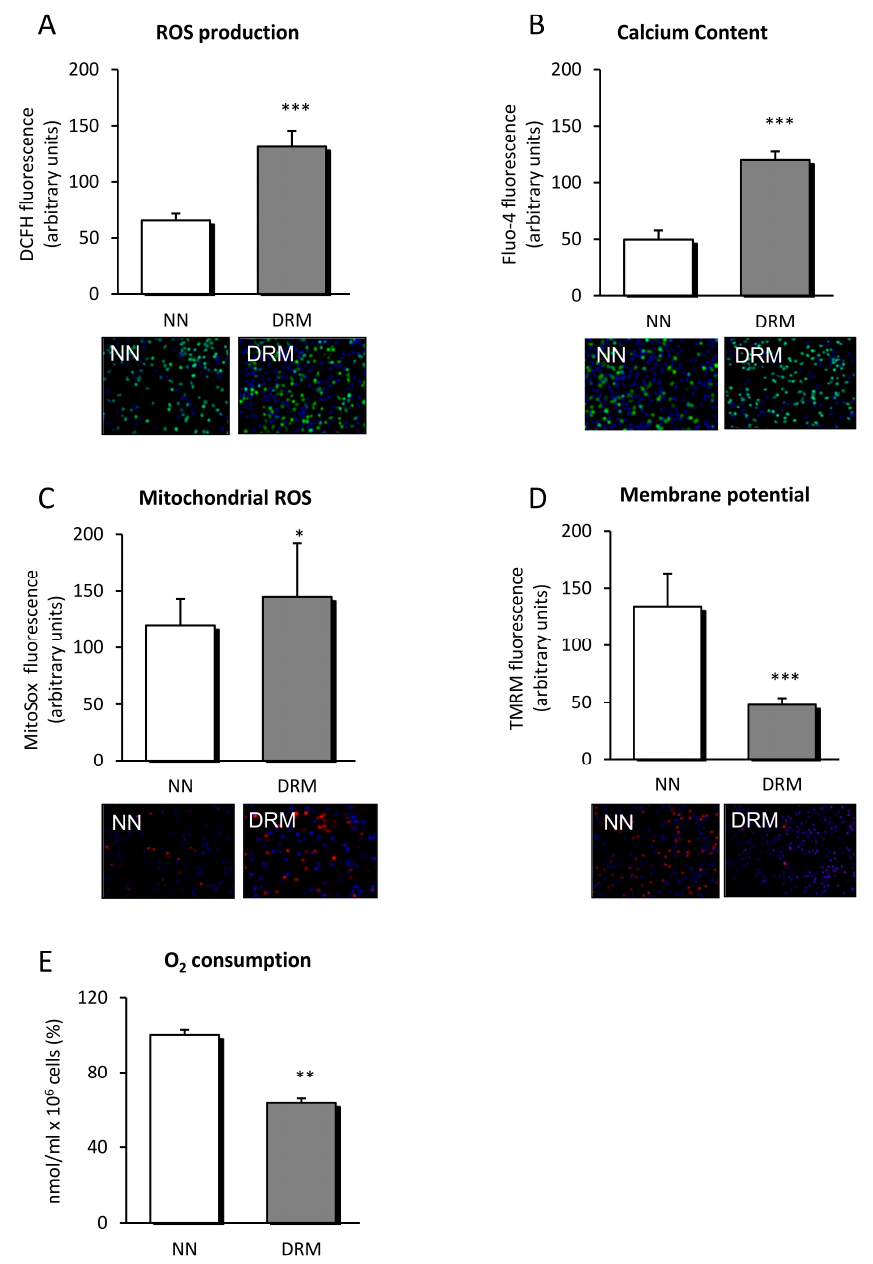
Figure 2. ROS production, calcium content and parameters of mitochondrial function measured in leukocytes from NN and DRM patients. ( A ) ROS production of leukocytes from NN and DRM subjects determined by measuring DCFH fluorescence in arbitrary units. Representative fluorescence images of both groups are displayed below the graph. ( B ) Calcium content of leukocytes from NN and DRM subjects determined by measuring Fluo-4 fluorescence in arbitrary units. Representative fluorescence images of both groups are displayed below the graph. ( C ) Mitochondrial ROS content of leukocytes from NN and DRM subjects, measured by TMRM fluorescence, in arbitrary units. Representative fluorescence images of both groups are displayed below the graph. ( D ) Mitochondrial membrane potential of leukocytes of NN and DRM subjects measured by TMRM fluorescence in arbitrary units. Representative fluorescence images of both groups are displayed below the graph. ( E ) Oxygen consumption of leukocytes from NN and DRM subjects with an oximeter. * p < 0.05, ** p < 0.01 and *** p < 0.001 vs. NN group using an unpaired t -test. NN: Normonutrition; DRM: Disease-related malnutrition; ROS: Radical oxygen species; DCFH: 2 (cid:48) ,7 (cid:48) -Dichlorofluorescein